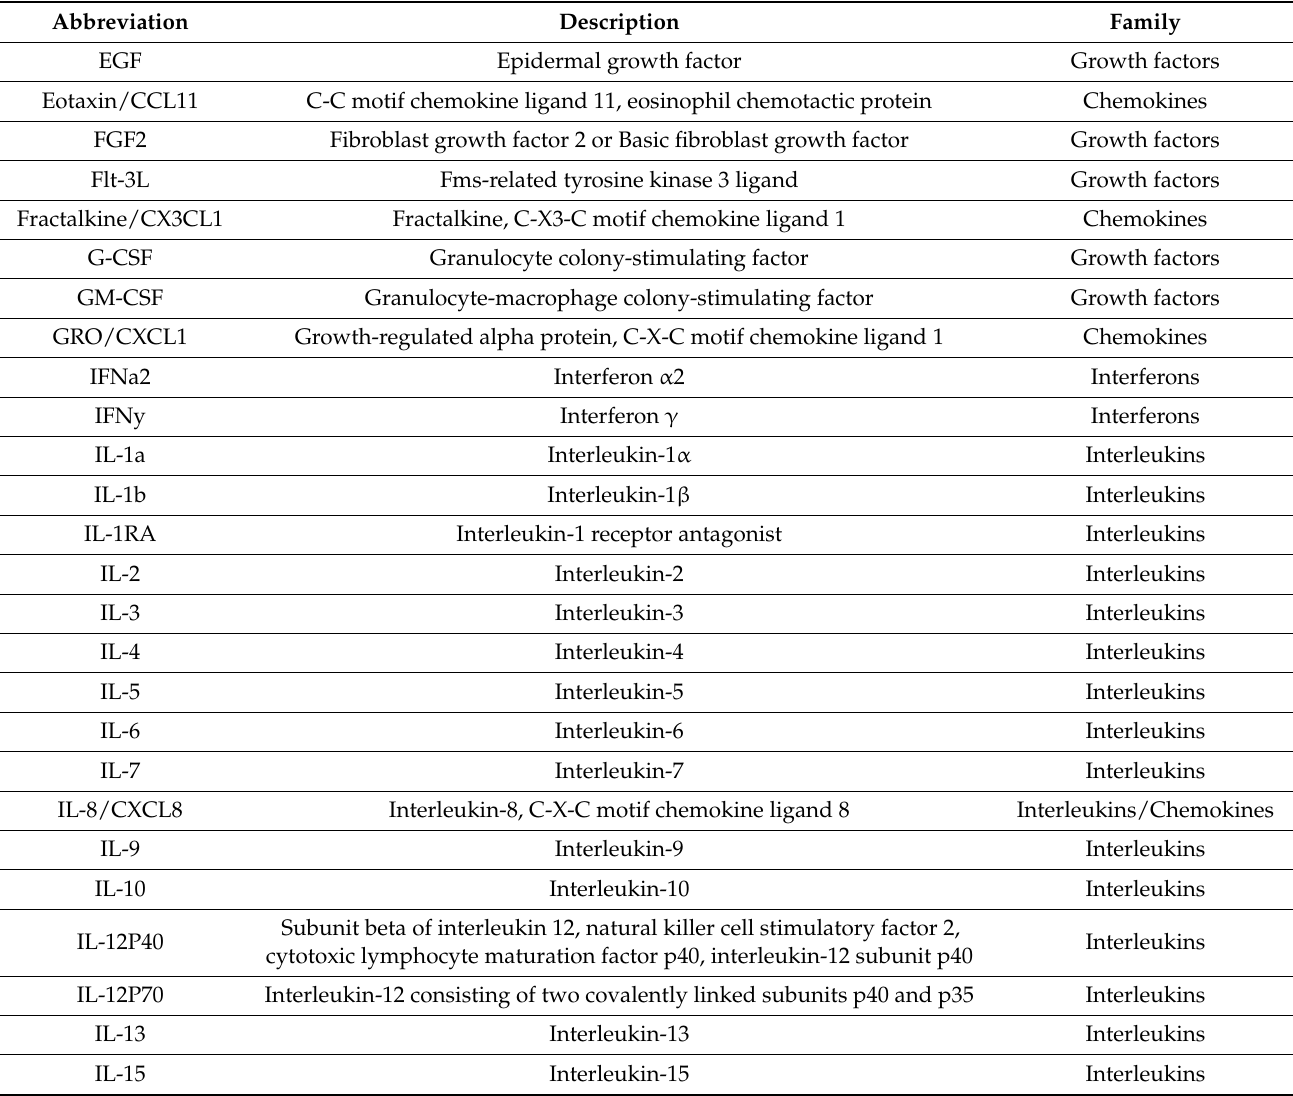
Table A1. Description of cytokines analyzed in the